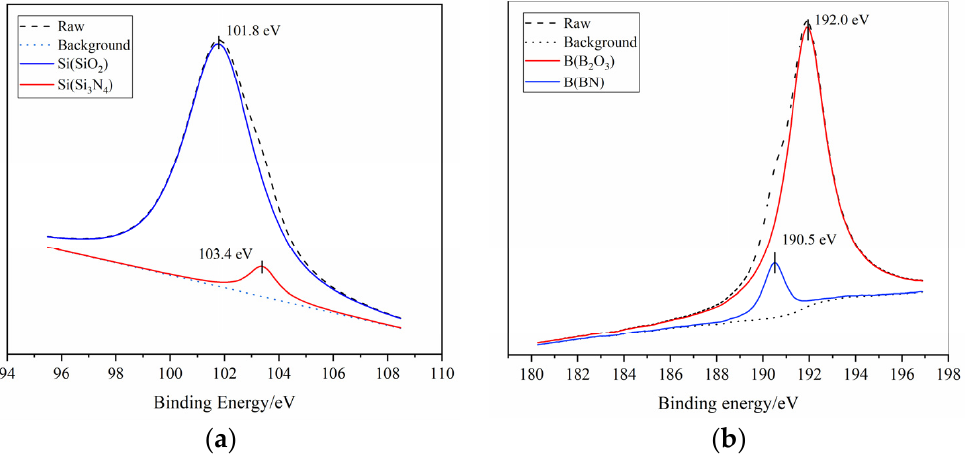
Figure 8. XPS spectra of the worn surface of the SN20 pin against the PEEK disc in artificial seawater: ( a ) Si2p; ( b ) B1s. ( a ) Si2p; ( b )